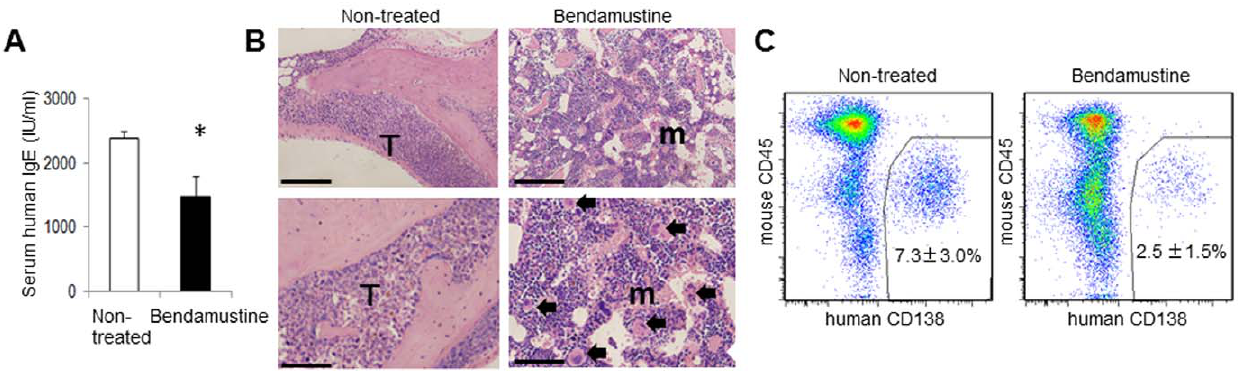
Figure 7. Bendamustine suppresses MM cells invivo . A. Serum levels of human IgE. Human IgE levels in the serum of NOG mice 4 weeks after treatment with bendamustine were analyzed by ELISA. Non-treated mice were injected with PBS (n=5, mean 6 SD). The experiment was performed three times with similar results. B. Histological studies of the thoracic vertebrae of NOG mice 4 weeks after treatment with bendamustine (right panel) or non-treatment (left panel). Massive infiltration of U266-EGFP cells was observed in non-treated mice. However, an overall reduction of U266-EGFP cells and maintenance of normal hematopoiesis were observed in bendamustine-treated mice. HE staining: T, tumor; m, marrow; arrow, megakaryocyte. Representative data from five fields from the BM of five mice per group from two independent experiments are shown. Upper panel bars=200 m m. Lower panel bars=100 m m. C. FACS analysis of U266-EGFP cells at 4 weeks after treatment in bendamustine-treated or non-treated mice (n=5, mean 6 SD). Representative FACS plots of at least 10 mice from two independent experiments are shown.